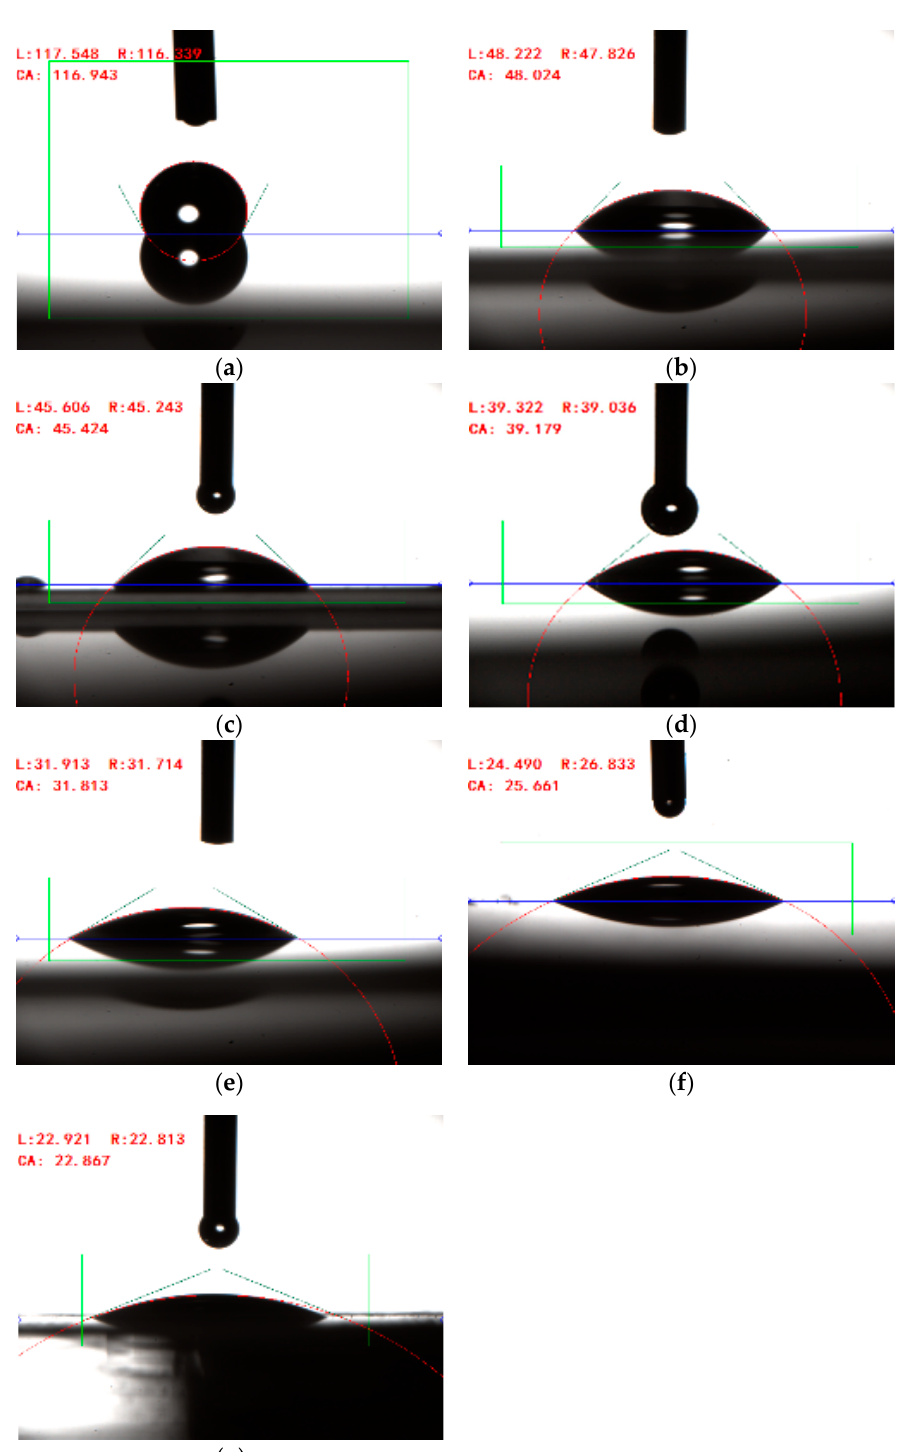
Figure 24. Contact angle of the mobile phone cover; ( a ) Contact angle before cleaning; ( b ) 500 W Contact angle after cleaning; ( c ) 600 W Contact angle after cleaning; ( d ) 700 W Contact angle after cleaning; ( e ) 800 W Contact angle after cleaning; ( f ) 900 W Contact angle after cleaning; and ( g ) 1000 W Contact angle after cleaning.